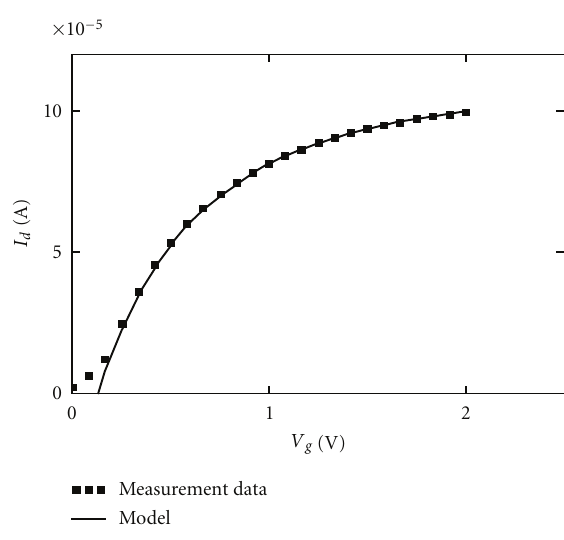
Figure 1: Transfer characteristics (symbols). Also shown is the cor- responding model (continuous line) obtained from the drain current model using the calculated parameters (Table 1).